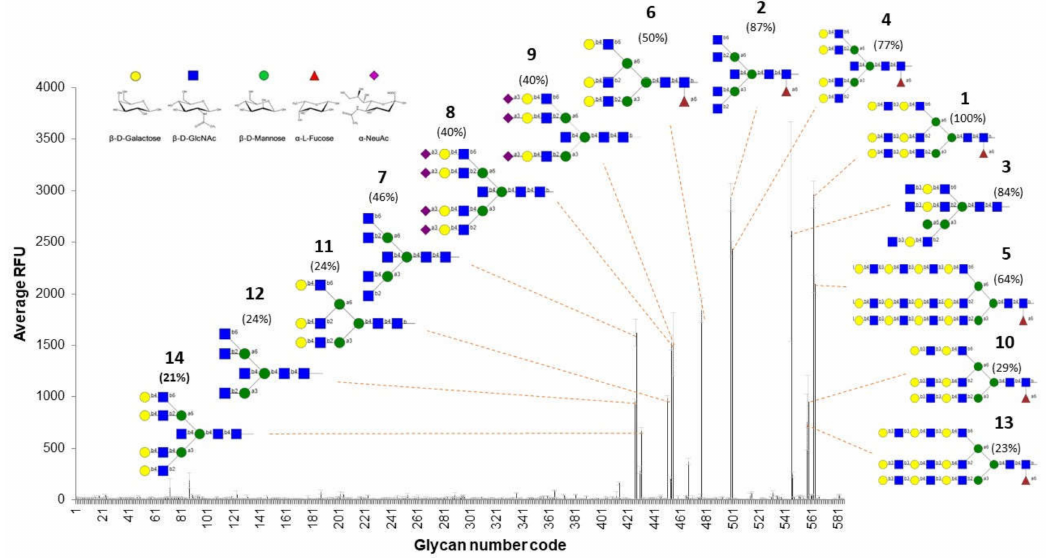
Figure 5. Glycan array results for rTBL-1 interaction with biologically relevant oligosaccharides: The bars show the average of the relative fluorescent units (RFUs) for each glycan of the matrix at 50 µ g / mL of rTBL1-FITC. Oligosaccharide structures of the top binders are shown attached to their corresponding signal. The numbers that accompany each structure indicate the ascending order of binders, starting with one as the highest RFU% (percentage of relative fluorescent units with respect to the strongest binder) for each glycan, and are indicated in parenthesis. The order of the binders and the RFU% were estimated considering the results obtained at 5 and 50 µ g / mL of